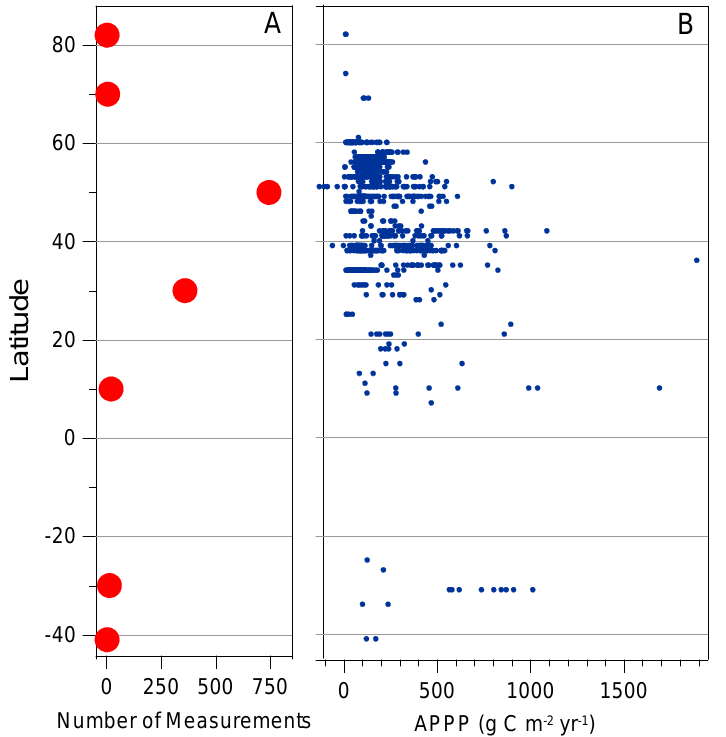
Fig. 2. ( A ) Distribution of effort, as the number of APPP measurements reported within 20 ◦ latitudinal bands, and ( B ) latitudinal distribution of 1148 APPP measurements (one value of − 692gCm − 2 yr − 1 from the Scheldt Estuary is not